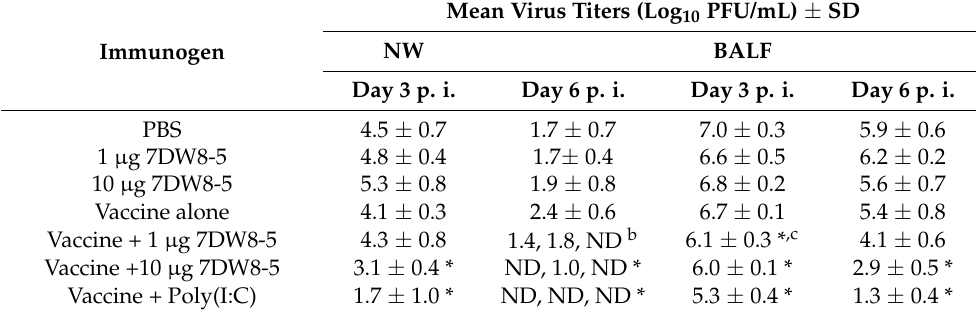
Table 1. Virus replication in the respiratory tract of immunized mice challenged with MA-CA04 virus a